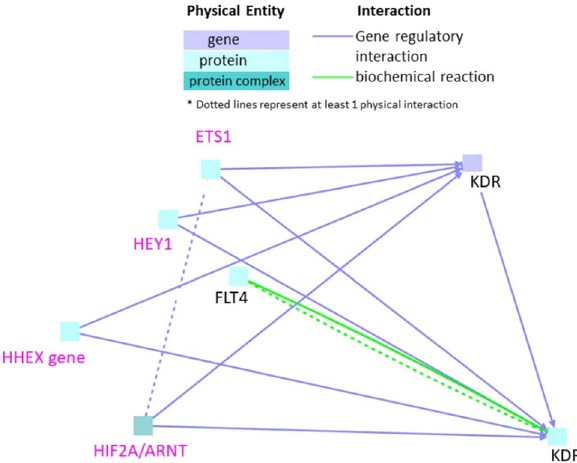
Figure 4. Interactions between genes that are downregulated in both neurotoxicity and cardiotoxicity. Black labels denote seed nodes and pink labels denote intermediate nodes. Each line represents an interaction. Dotted line represents at least one physical interaction.